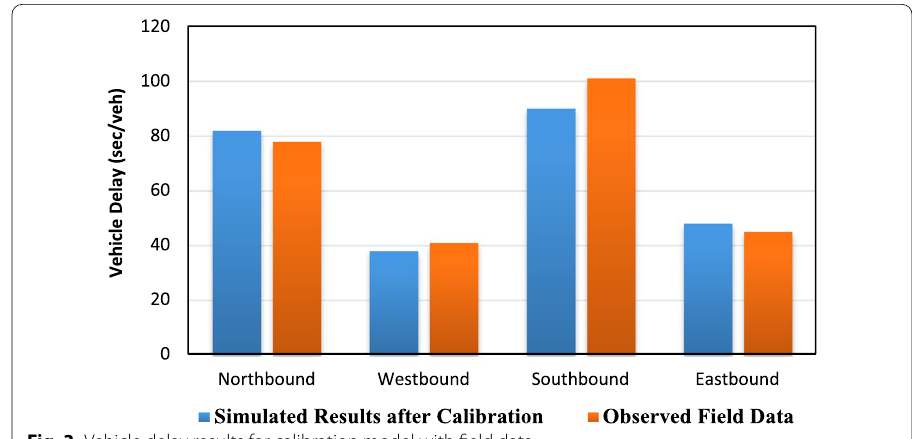
Fig. 3 Vehicle delay results for calibration model with field data